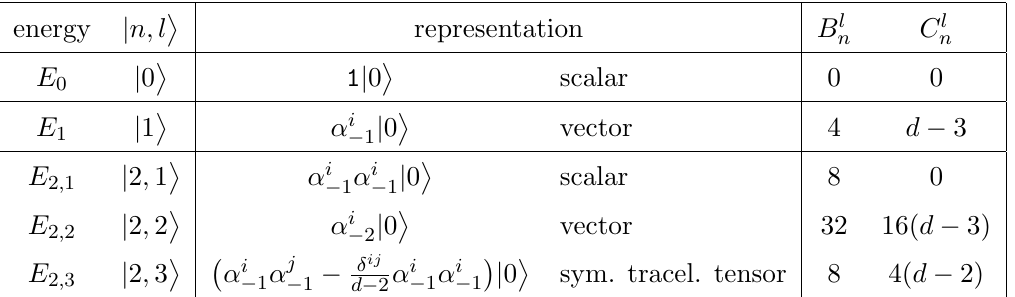
Table 1 . String states in the lowest three energy levels and their representation in terms of creation operators (cid:11) m in the Fock space together with their representation with respect to SO( d also list the associated values for the numbers B l (cid:11) for the state 2 ; 3 stands for ‘symmetric j